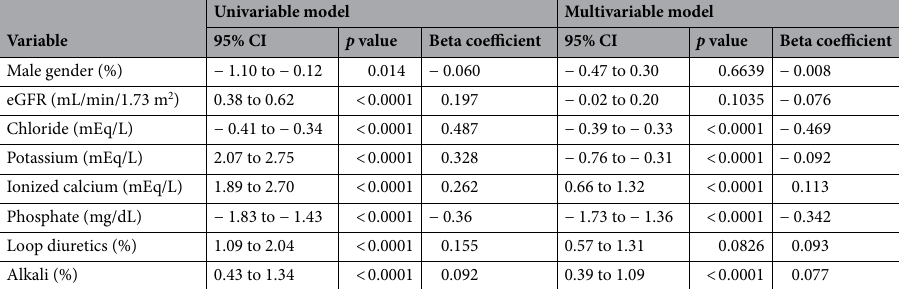
Table 6. Univariable and multivariable regression analysis of serum